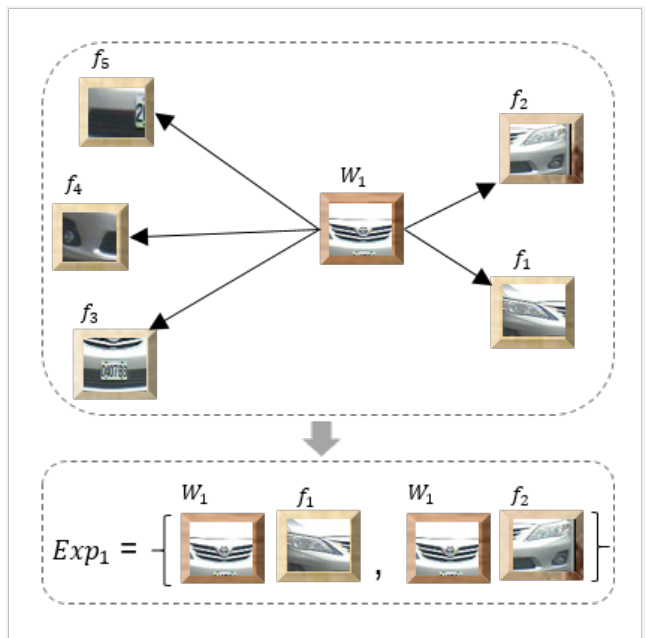
Figure 6. Visual expression generation (for illustrative purposes N has been set to 2 and only one visual word is